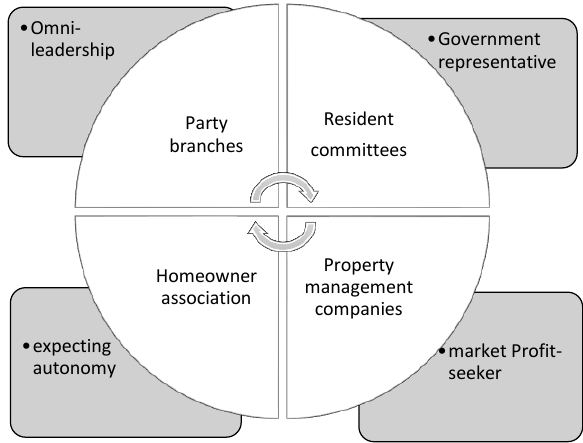
Fig. 1. The compound identity of community in China (developed by the